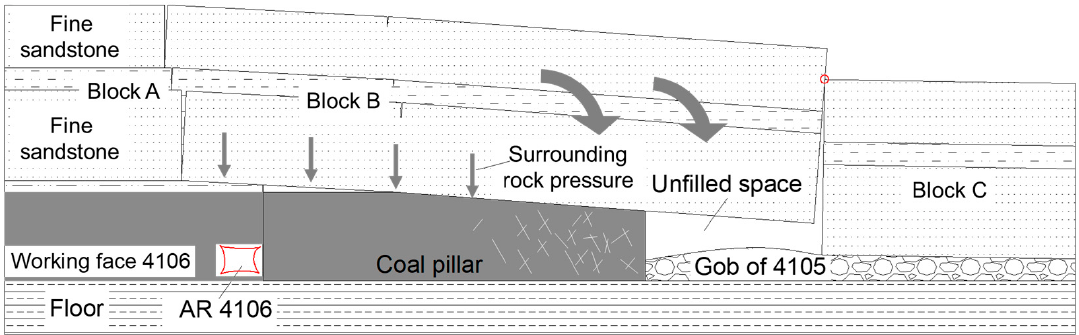
Figure 11. Crack expansion of short bolt support. Figure 12. Failure characteristics of hard roof roadway in extra-thick coal seam.